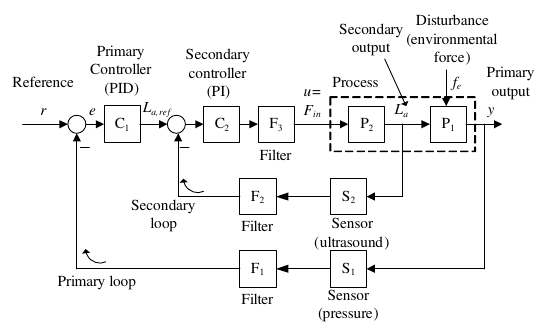
Figure 4: Cascade control